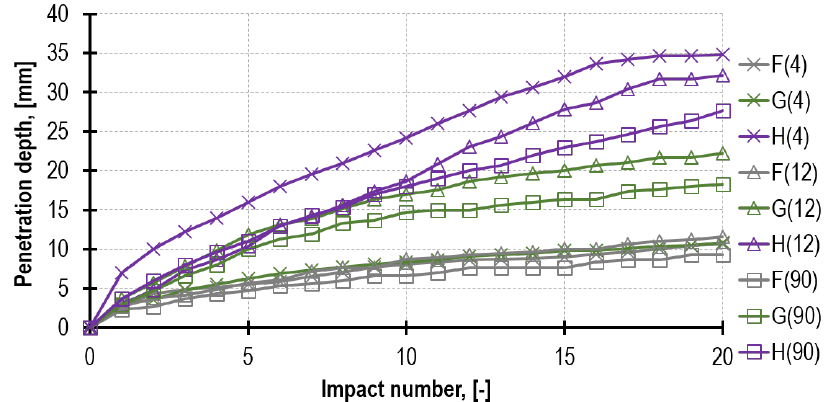
Figure 12. The averaged results of all the penetrometric tests (surface and downhole) for mortar F, G and H performed in 3 time intervals, after 4, 12 and 90 weeks.